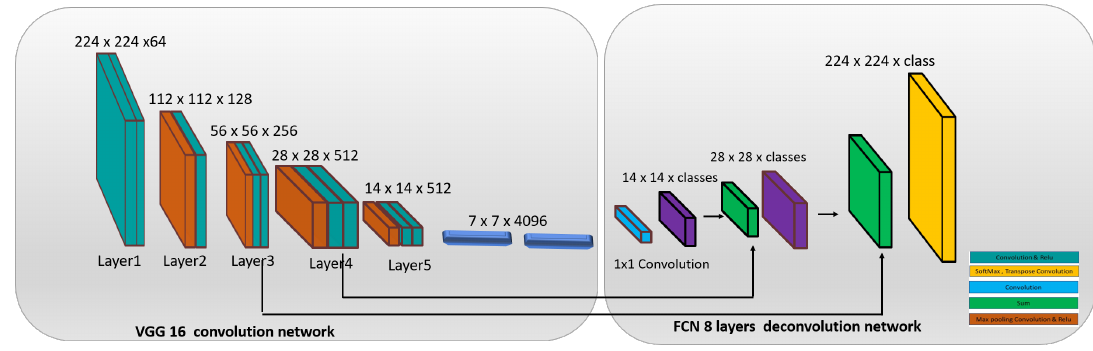
Figure 2. FCN8 Network